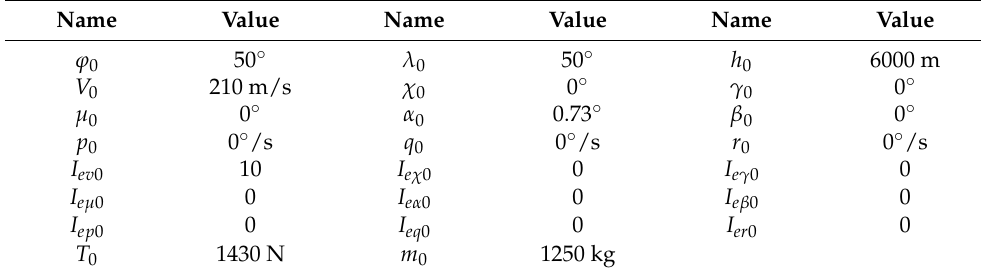
Table 5. Initial state settings of the morphing aircraft and the integrators in Section